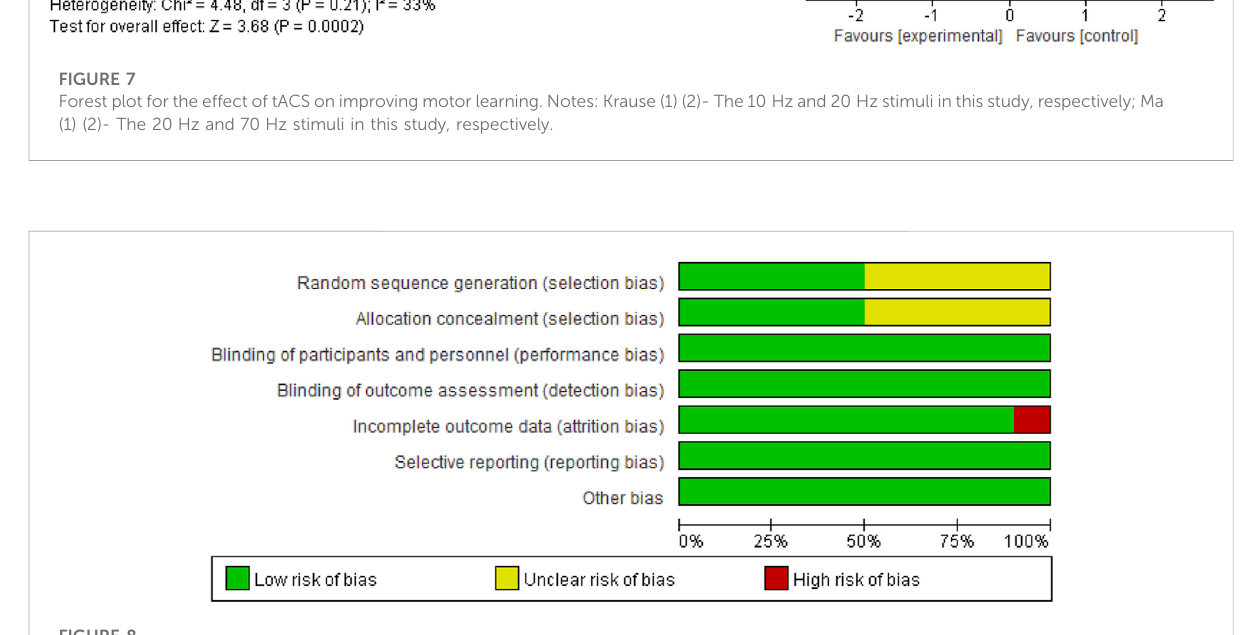
FIGURE 8 Risk of bias in included